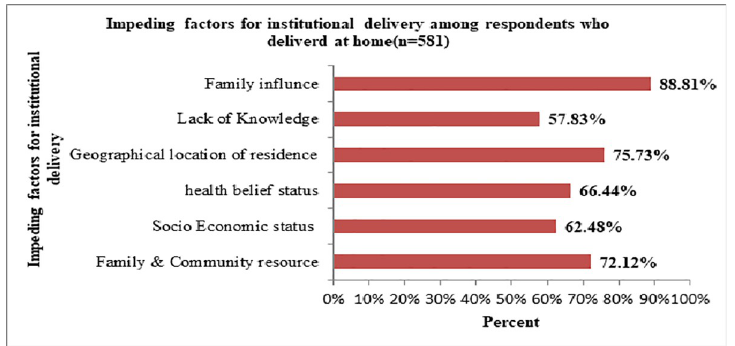
Fig 2. Impeding factors for institutional delivery among respondents who delivered at home, Central Gondar zone, North West Ethiopia, 2020.